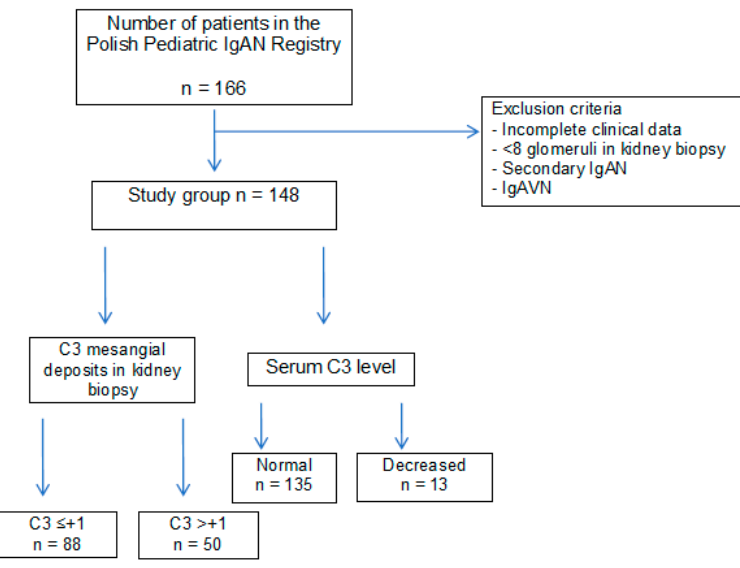
Figure 1. Flow diagram of the study.